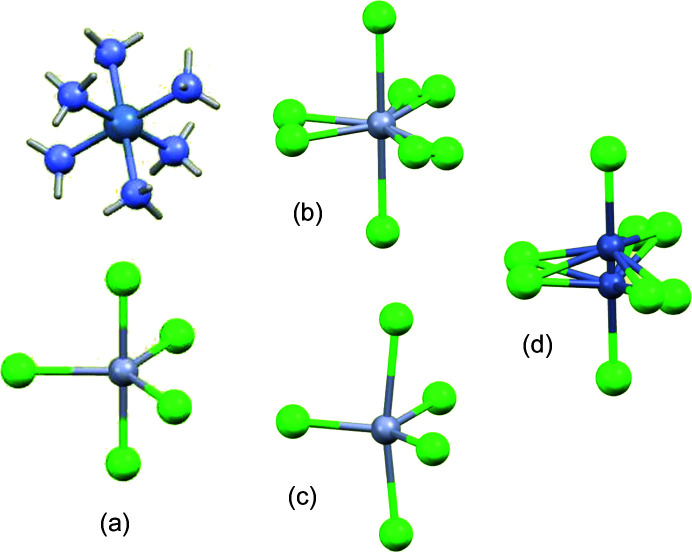
Distortions and disorder of [MCl5]3− structures based on a trigonal bipyramid.